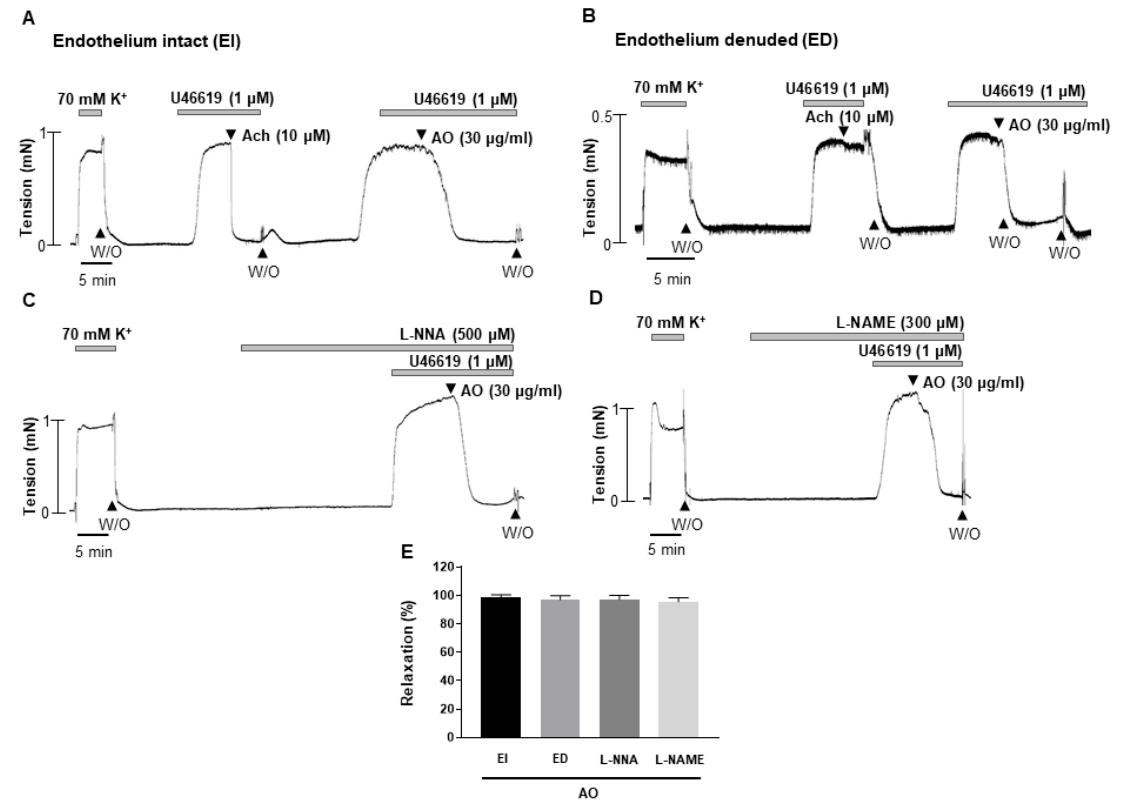
Figure 2. Endothelium-independent vasodilation induced by A. officinarum extract. ( A ), A. officinarum extract-induced vasodilation in the endothelium intact mesenteric arteries. ( B ), A. officinarum extract-induced vasodilation in the endothelium denuded mesenteric arteries. ( C ), A. officinarum extract-induced vasodilation in the presence of eNOS inhibitor L-NNA (500 µM). ( D ), A. officinarum extract-induced vasodilation in the presence of eNOS inhibitor L-NAME (300 µM). ( E ), statistical analysis of A. officinarum extract-induced vasodilation. Mean ± SD (n = 5). (Ach: acetylcholine; W/O: wash out; AO: Alpinia officinarum extract; L-NNA: N- ω -Nitro-L-arginine; L-NAME: N- ω -Nitro-L-arginine methyl ester).